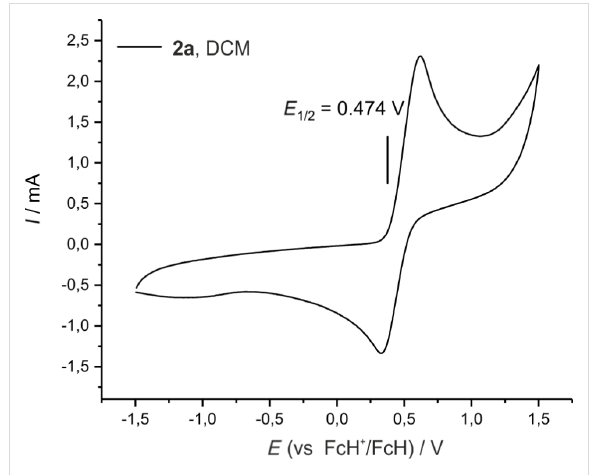
Figure 7: Cyclic voltammogram of 2a in DCM, 0.2 M n- Bu 4 NPF 6 , 1 V s − 1 scan rate, referenced vs FcH/FcH +